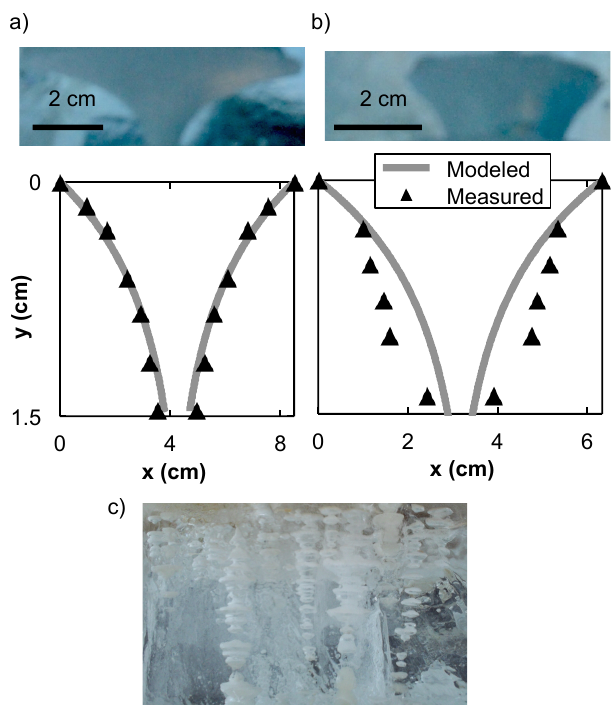
A-type ebullition seep. Field measurements of bubbles (a) and (b) are compared to shapes calculated in the bubble dissolution com- ponent of the model (Sect. 2.3.3). Plots represent a side profile of bubbles, with the y axis representing depth within the ice layer. Note the different scales on both axes. (c) Encapsulated bubbles oriented in both directions, either with flat bottoms and tapering tops or vice- versa. Photos courtesy of Melanie